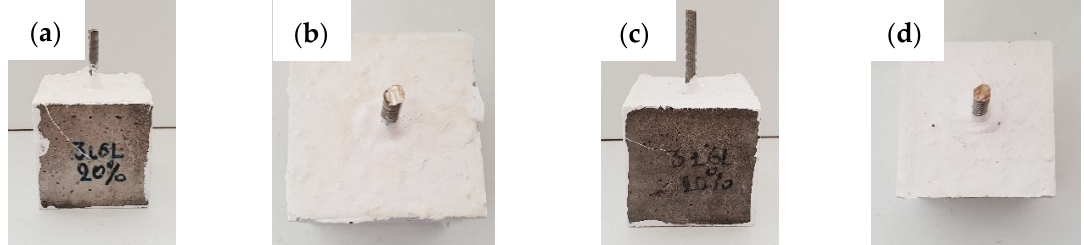
Figure 1. Concrete cubes reinforced by 316L having undergone salt fog test for 4 months: ( a ) and ( b ): 20% fly ash; ( c ) and ( d ) 20% fly ash + Inhibitor B.